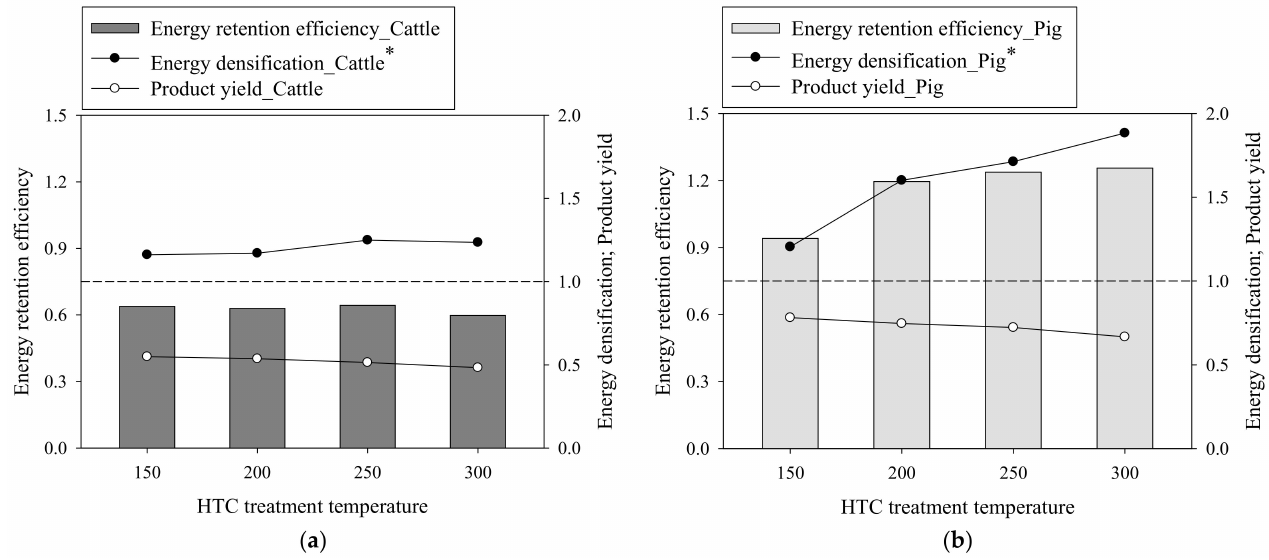
Figure 4. Energy-related properties of the SHW-derived hydrochars for ( a ) cattle and ( b ) pig. * Energy densification of the raw SHW without hydrothermal carbonization (HTC) =